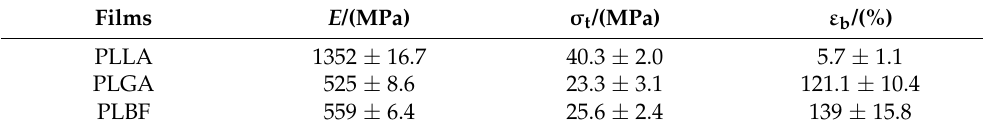
Table 2. Mechanical properties of PLLA/PLGA/PLBF modified atmosphere breathing membrane.